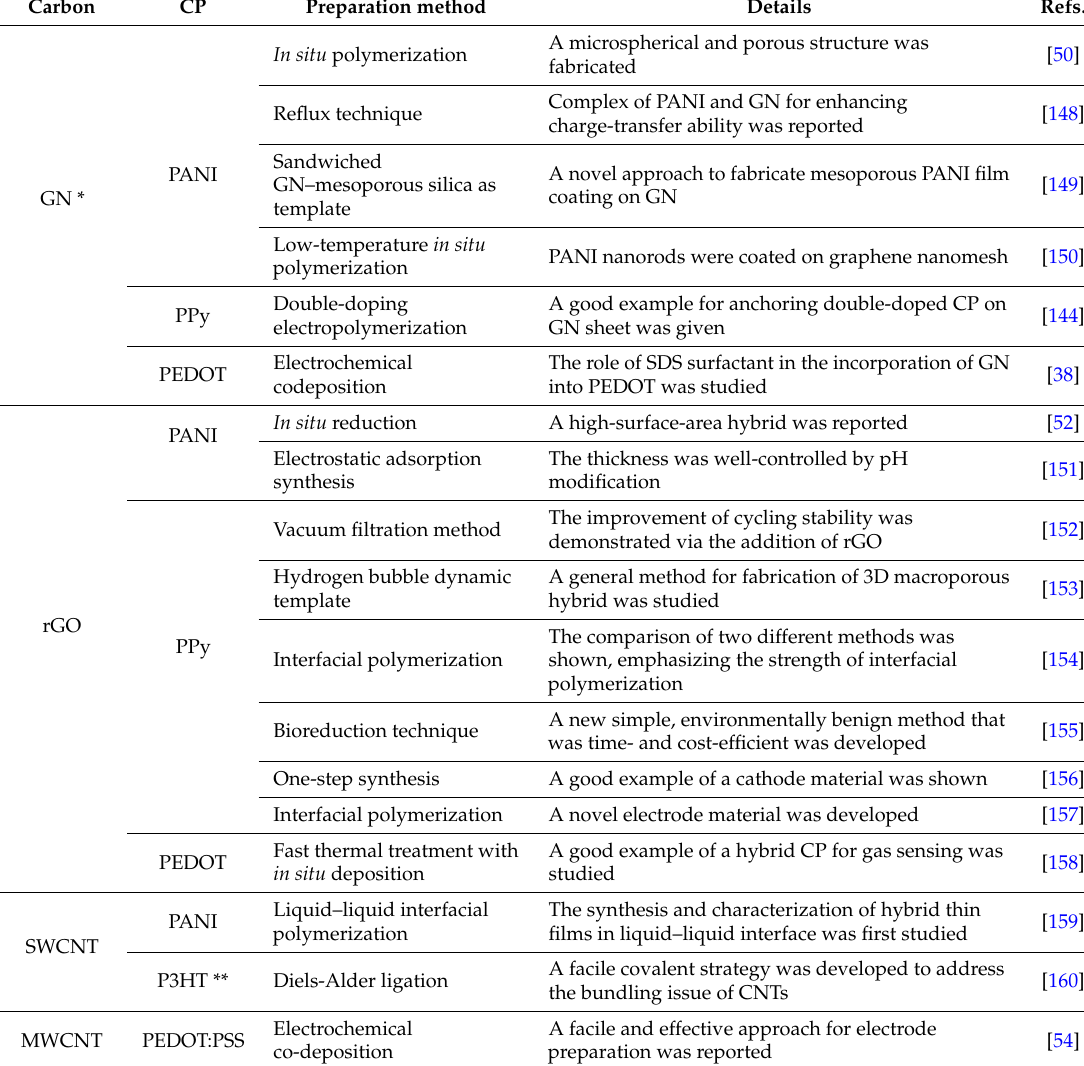
Table 8. Representative examples of studies where carbon nanomaterials were incorporated into CPs. Carbon CP Preparation method Details